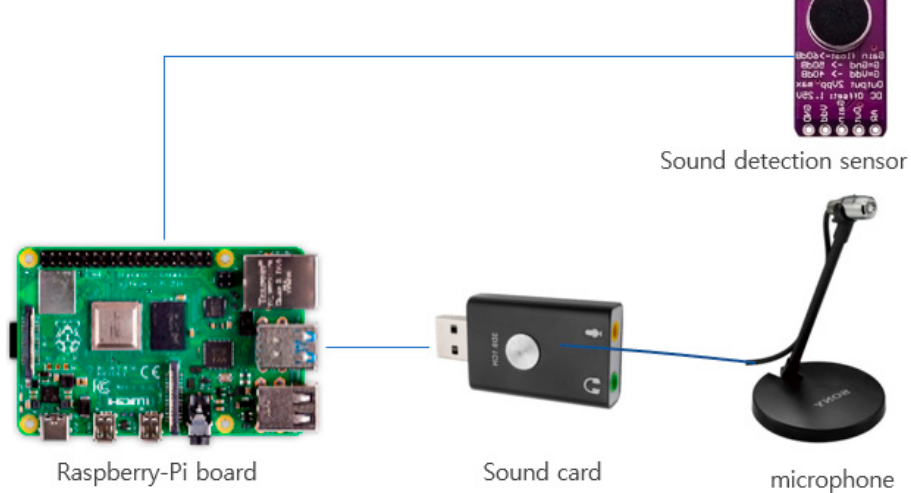
Figure 7. Hardware configuration for sound detection and